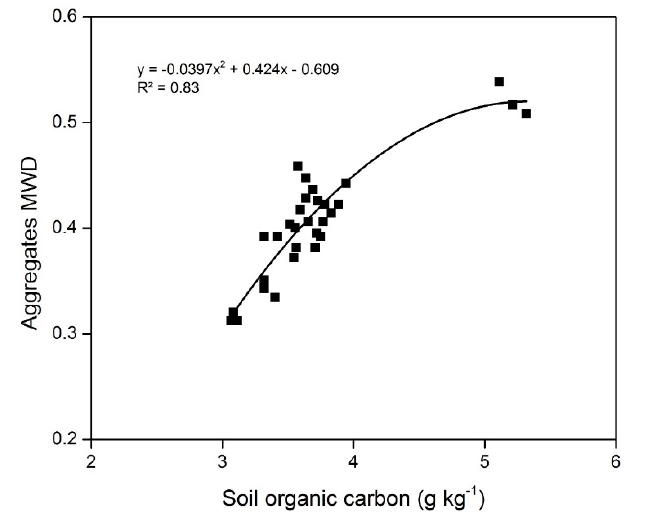
Figure 4. Relationship between soil organic carbon and aggregate